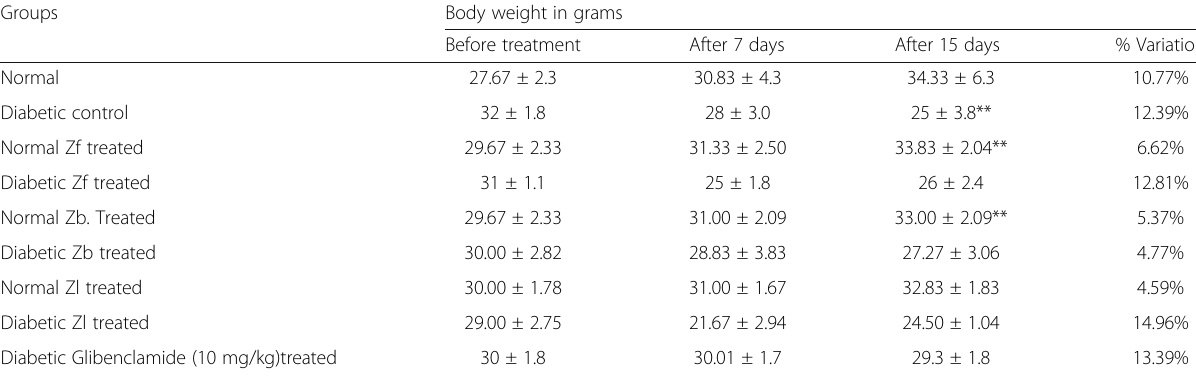
Table 1 Effect of extracts of Zanthoxylum armatum and standard drug Glibenclamide on body weight of normal and alloxan monohydrate induced diabetic mice